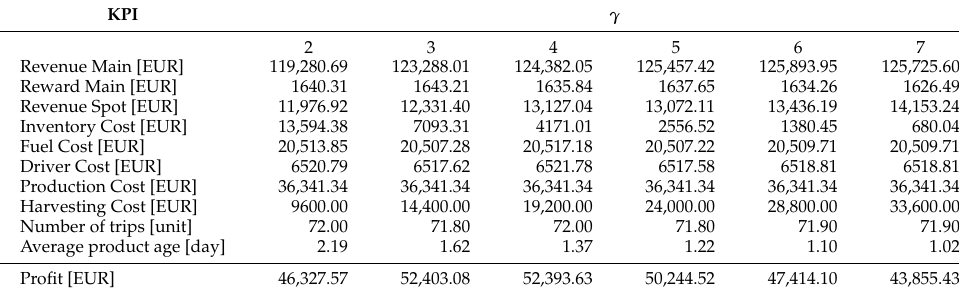
Table 10. Average KPIs for the case of θ = 10 h (company C 1 ).